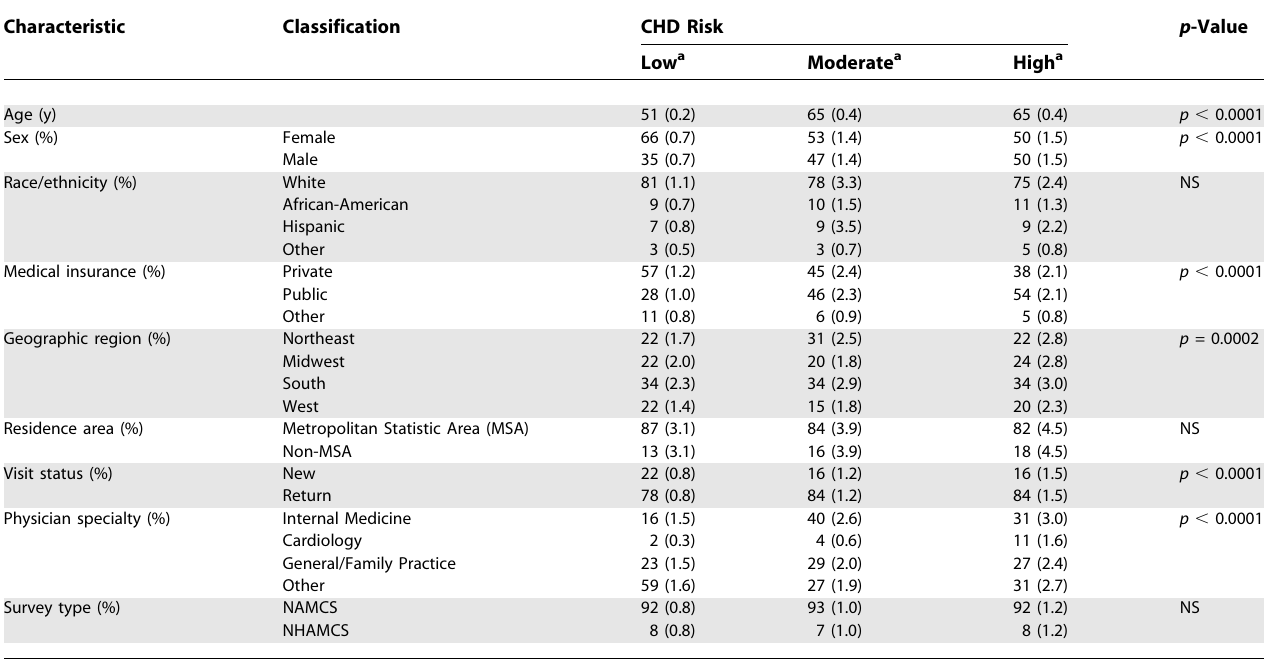
Table 1. Differences in Patient, Physician, and Visit Characteristics by CHD Risk in 2002 Characteristic